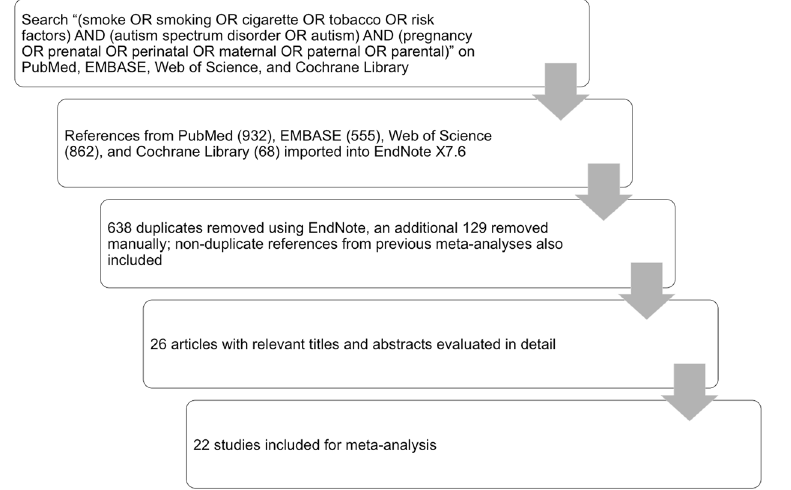
Figure 1. Study selection